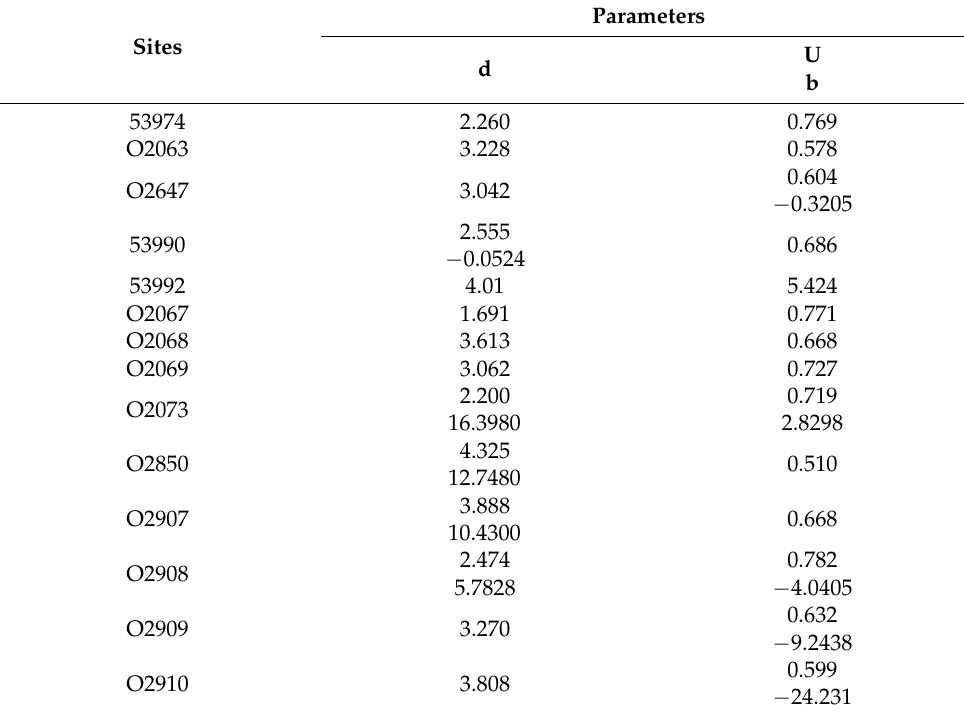
Table 2. The mean Manhattan distance (d) and mean uncertainty (u) at each site.